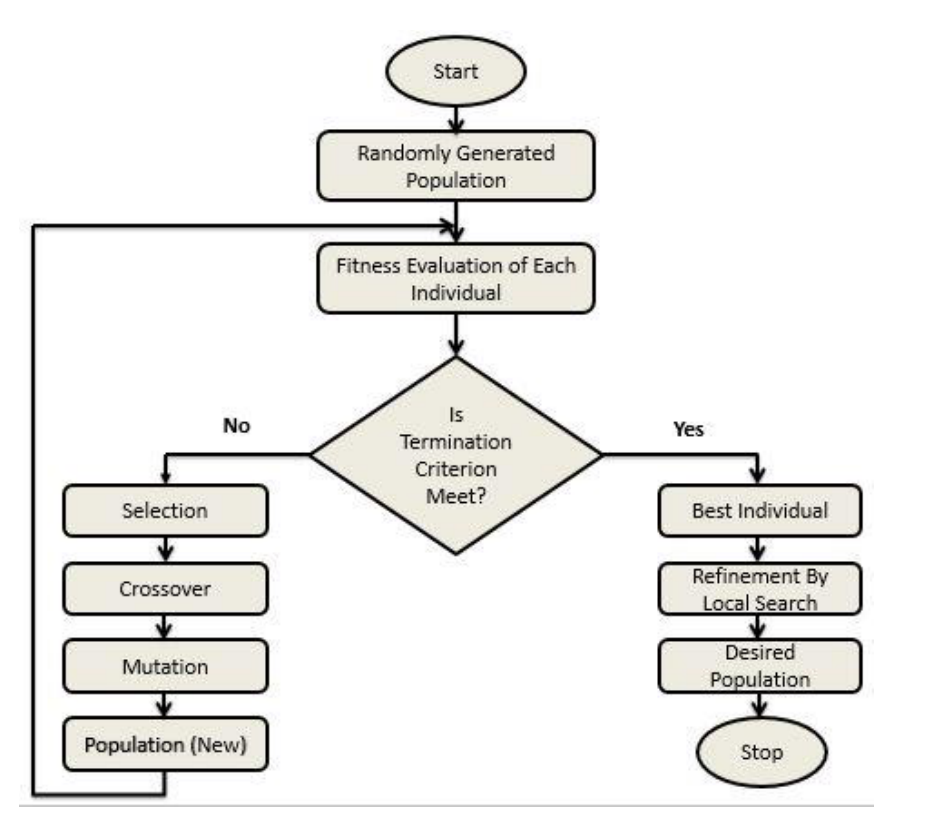
Figure 2. Flow diagram for hybrid GA – PS.